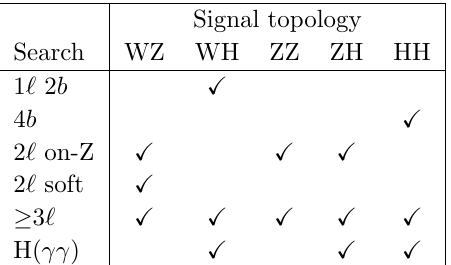
Summary of all experimental searches considered in the combination (rows), and the signal topologies for which each search is used in the combined results (columns). The searches are described in sections 5.1 through 5.6 and section 6. The (cid:21) 3 ‘ search described in section 5.5 is used for all signal topologies except for WZ, where the reoptimized search strategy from section 6 is employed